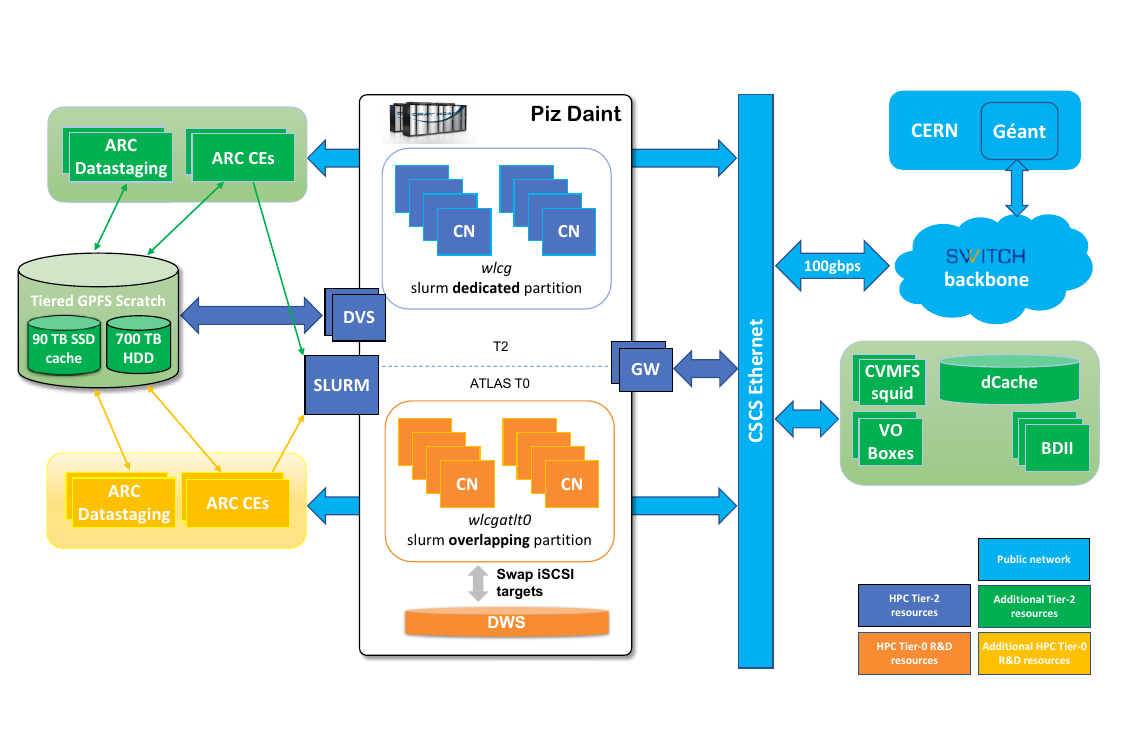
Figure 2. CSCS Tier-2 architecture with Piz Daint and Tier-0 R&D